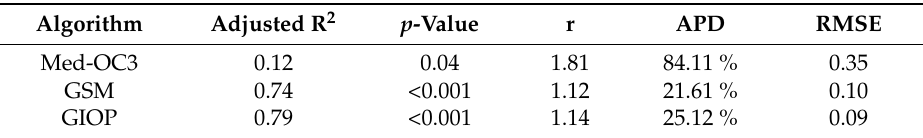
Table 4. Regression indices and statistical indicators for the chl-a match-up analyses (see Section 2.4 for definitions).